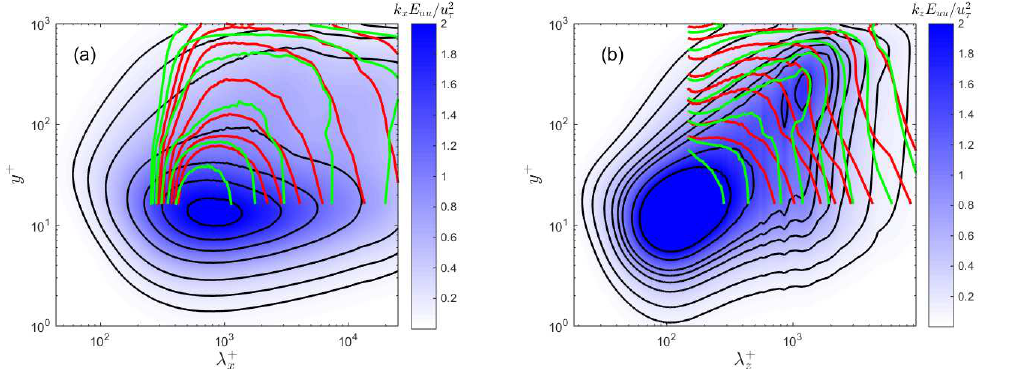
Figure 15. ( a ) Normal and ( b ) shear Reynolds stresses of turbulent channel flow by WMLES at Re τ = 1000.